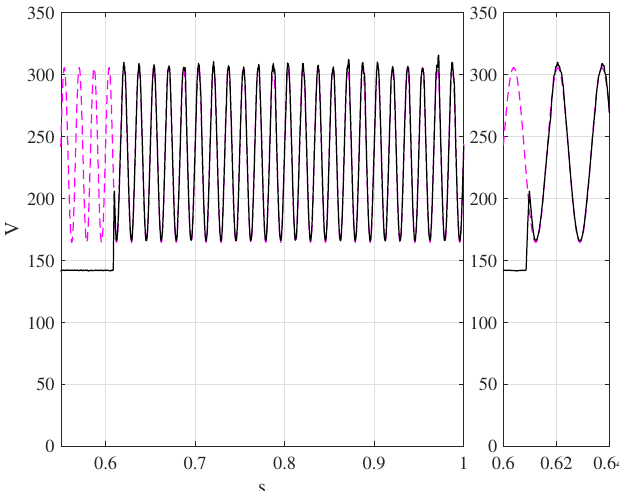
Figure 5. Output tracking of the capacitor voltage with α = 377 (60 Hz). Reference signal in dashed line, and capacitor voltage in solid